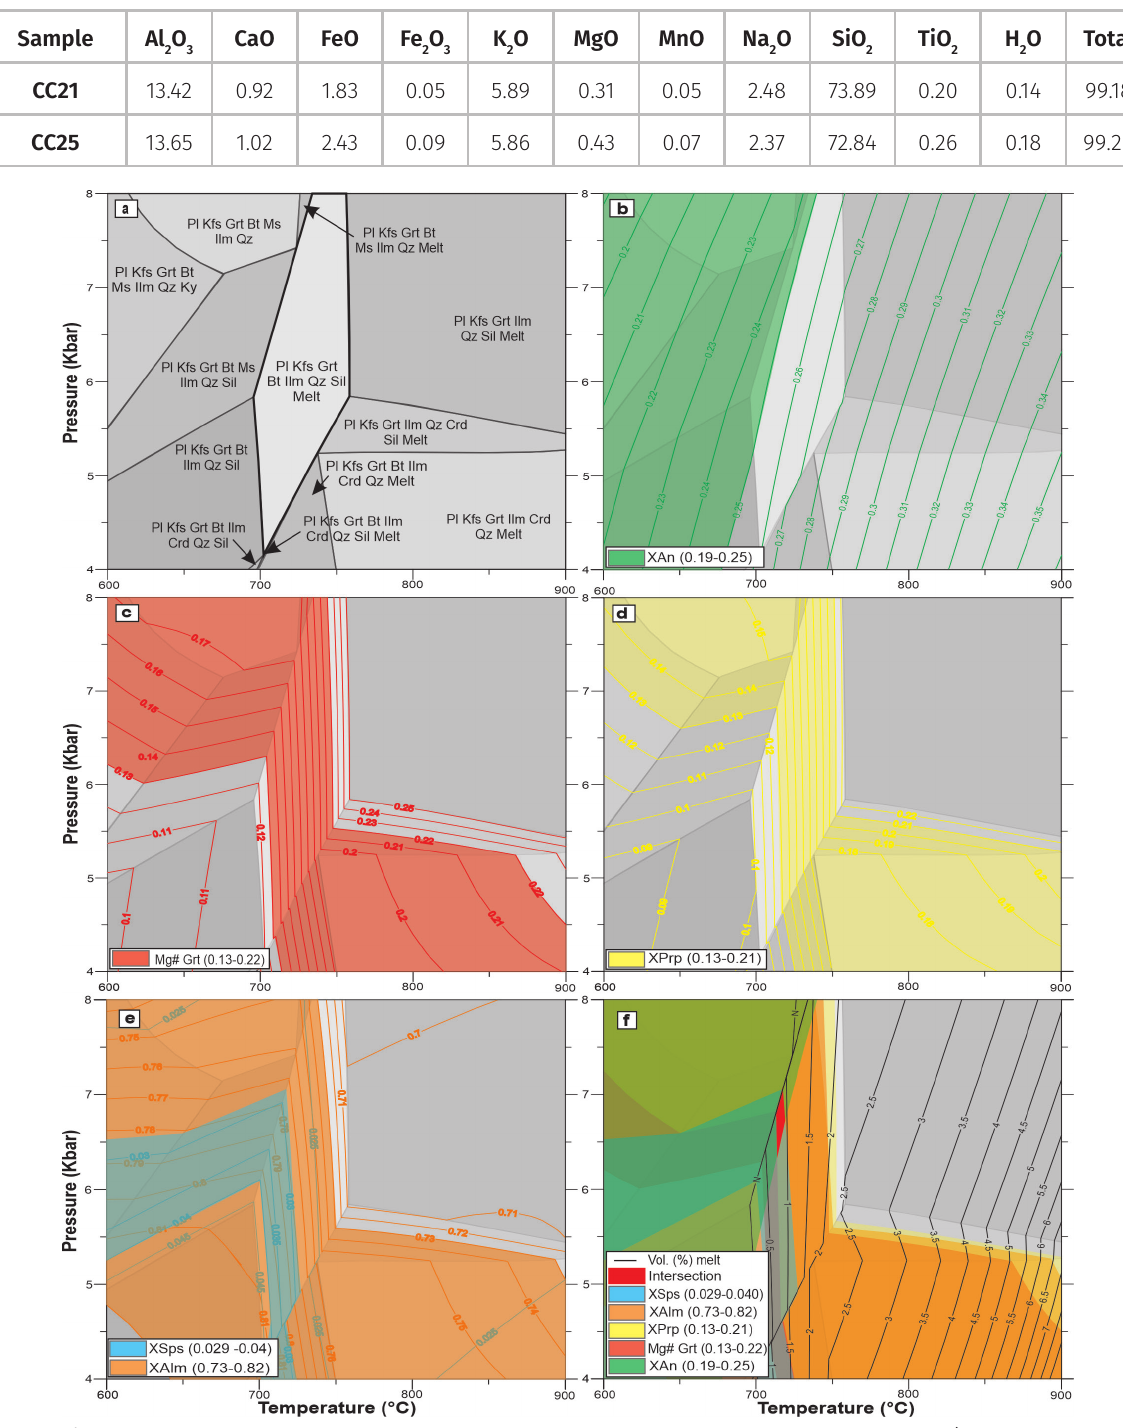
Figure 9. P–T pseudosection calculated using the bulk composition from sample CCS-21 (A assemblage). (a) P–T fields showing the preserved assemblage Kfs+Pl+Qz+Grt (bold line). (b) Plots of X P–T conditions of equilibrium based on the use of overlapping ranges of phase